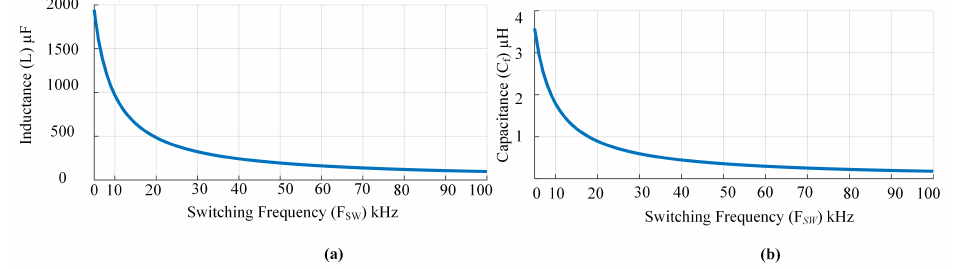
Figure 5. ( a )The relationship between the switching frequency ( F SW ) and the inductance value. ( b ) The relationship between the switching frequency ( F SW ) and the capacitance value.